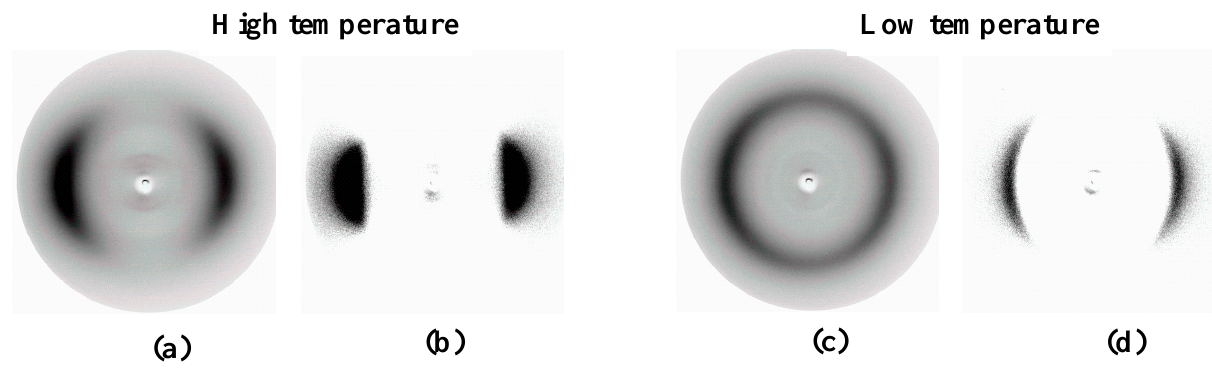
Figure 12. XRD patterns of an aligned sample of mixture MGTP208 in the magnetic field upon cooling. ( a , b ) XRD patterns of the nematic phase at 97 °C: ( a ) original pattern; ( b ) the same XRD pattern, but the intensity of the isotropic liquid is subtracted. ( c , d ) XRD patterns of the N at 70 °C: ( c ) original pattern; ( d ) the same XRD pattern, but x the intensity of the isotropic liquid is subtracted.